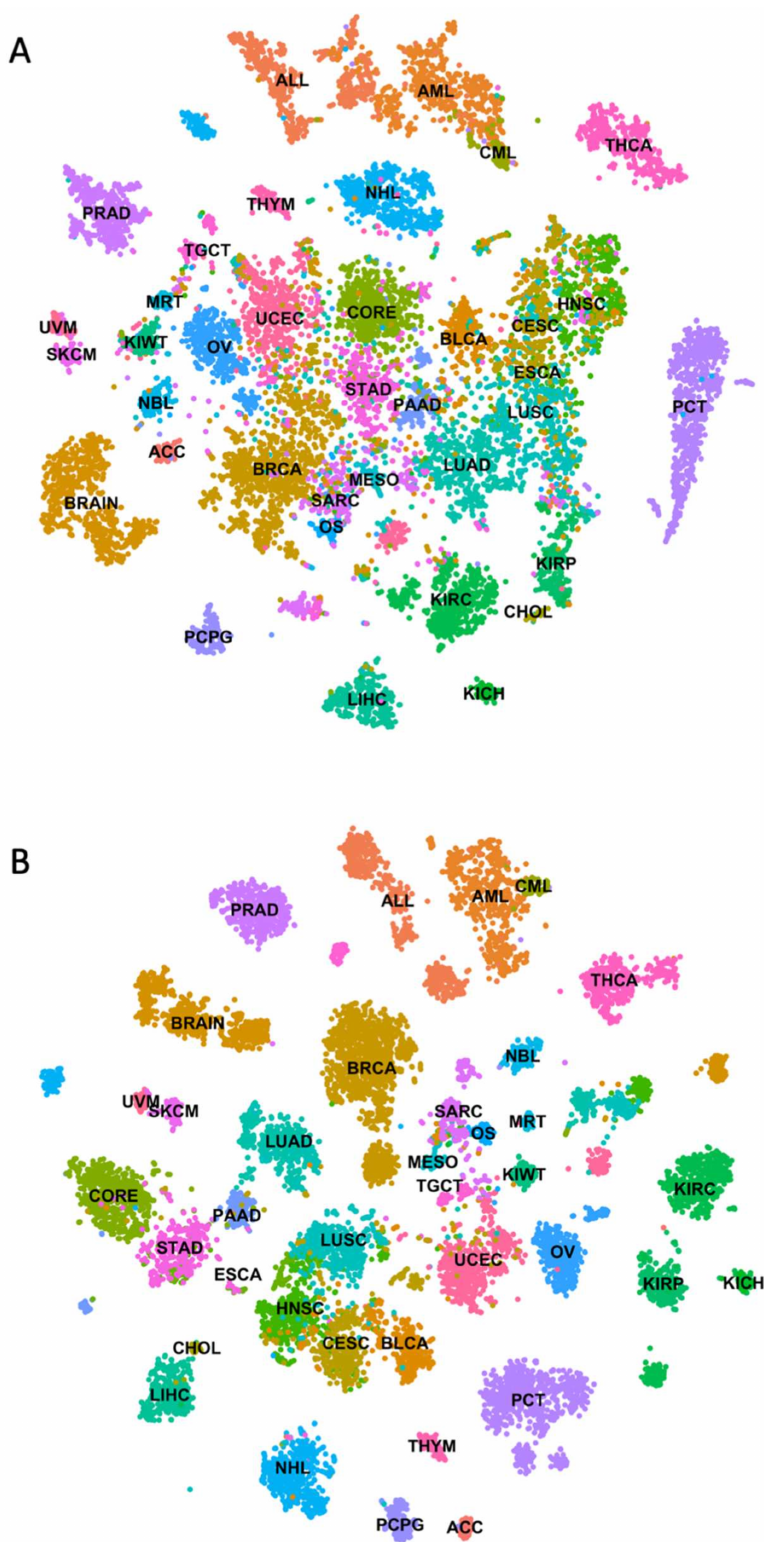
Figure 1. Unsupervised clustering of the cancer genome atlas RNA-seq data using t-distributed stochastic neighbor embedding. ( A ) t-distributed stochastic neighbor embedding plot showing unsu- pervised clustering of transcriptome data from the cancer genome atlas without log transformation ( B ) t-distributed stochastic neighbor embedding plot showing unsupervised clustering of transcrip- tome data from the cancer genome atlas after log